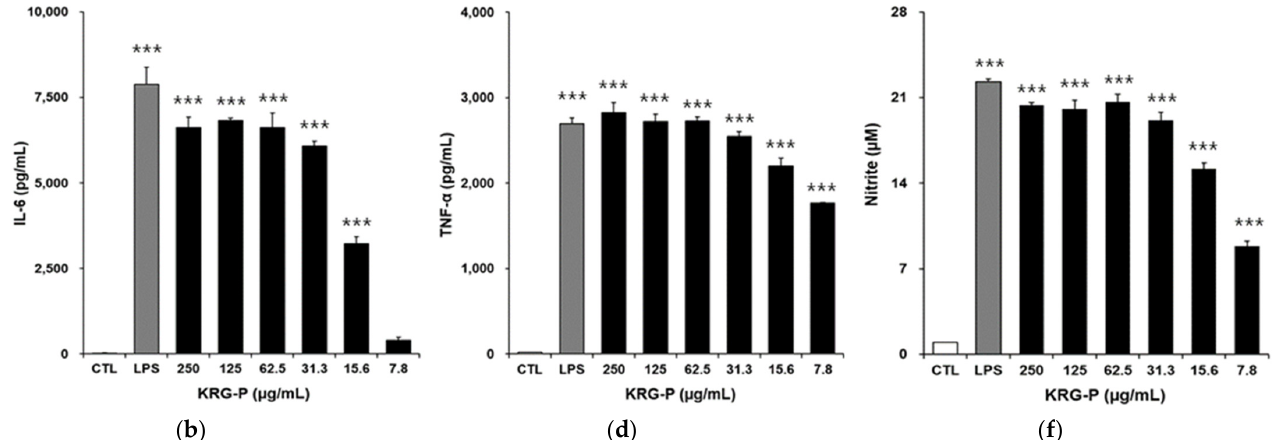
Figure 2. Effect of KRG and KRG-P on the production of IL-6 ( a , b ), TNF- α ( c , d ), and NO ( e , f ) in RAW264.7 macrophage cells in vitro. RAW264.7 macrophage cells (1.0 × 10 5 cells/well) were treated with KRG and KRG-P using a series of concentrations (7.8~250 µg/mL) or LPS (500 ng/mL) in 96-well flat-bottomed microplates for 24 h. The supernatants were collected for the measurement of cytokines including IL-6 ( a , b ), TNF- α ( c , d ), and NO ( e , f ). CTL; control, LPS; lipopolysaccharide. Data are presented as the means ± SD of three independent experiments. *** p < 0.001 vs. the control group.